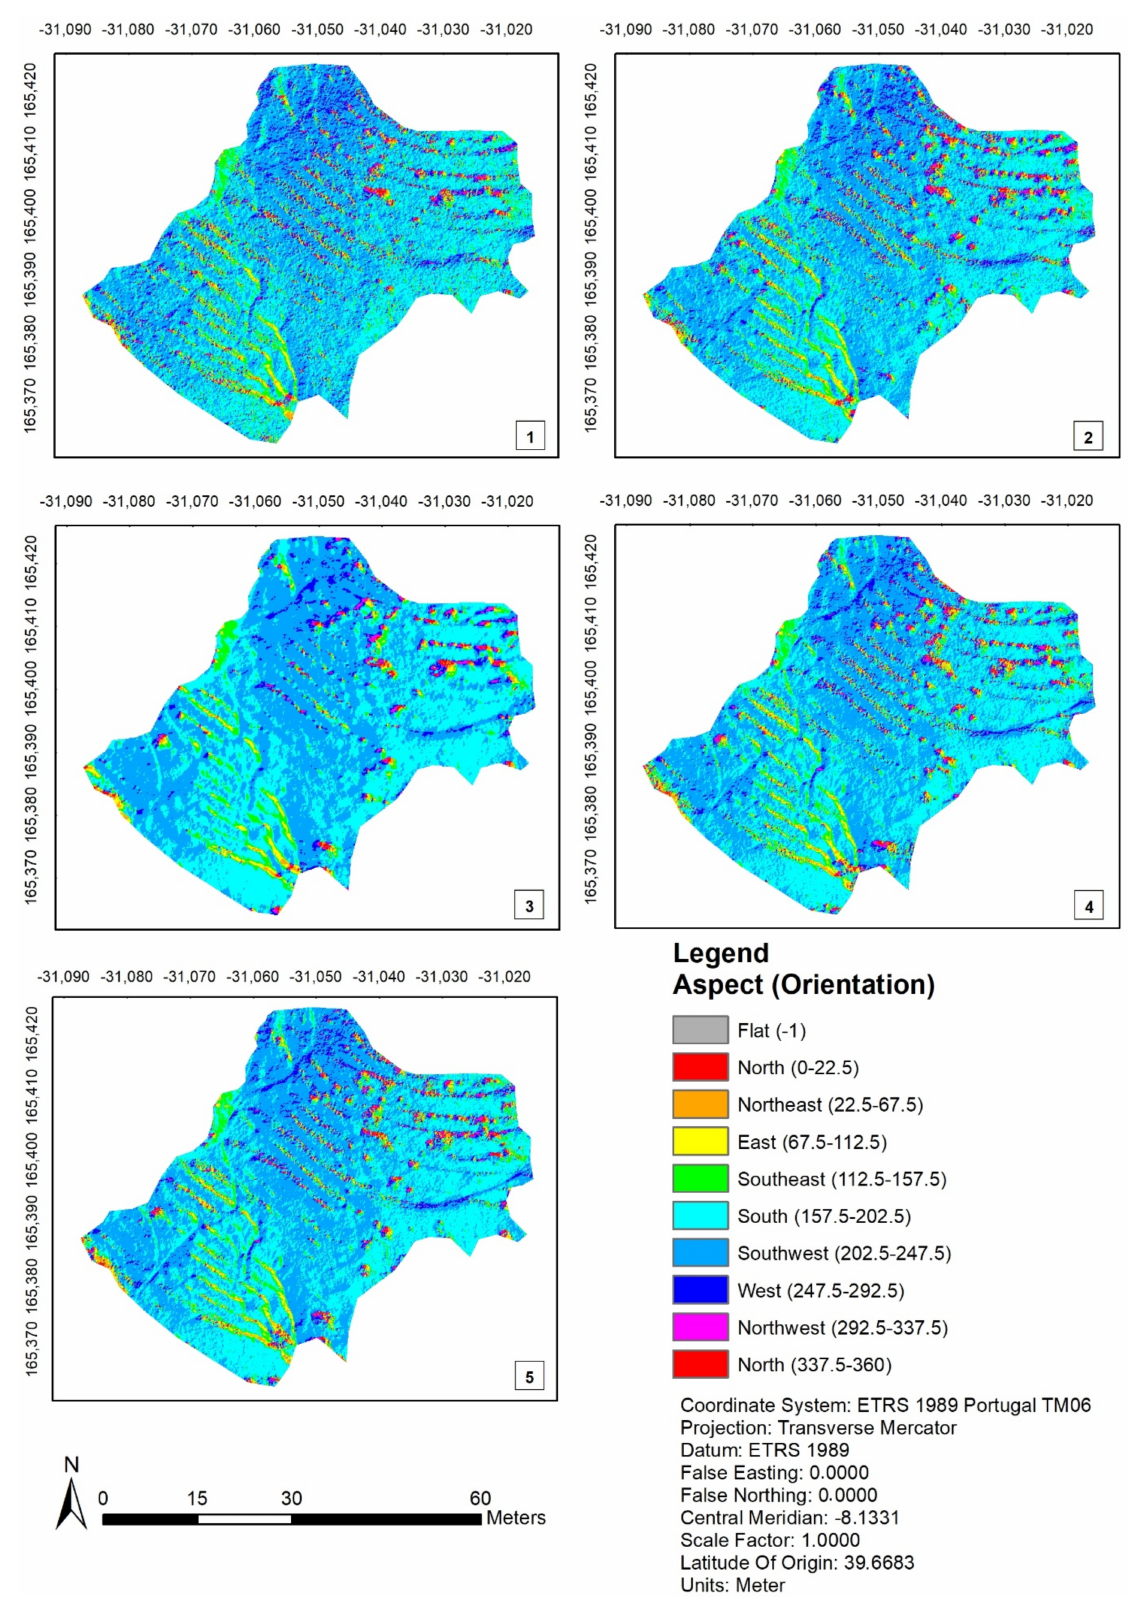
Figure 7. Maps of the temperature variation obtained in each campaign (1—July 2019; 2—December 2019; 3—May 2020; 4—August 2020; 5—November